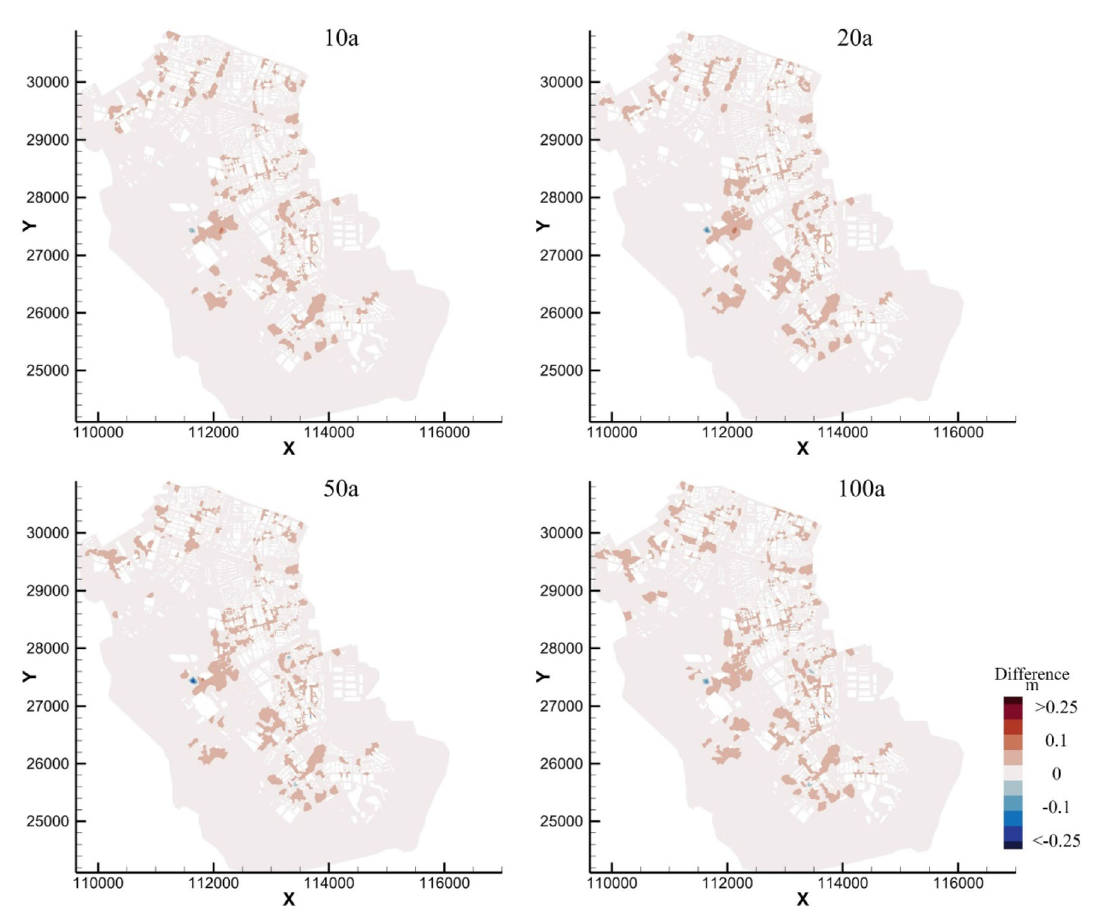
Fig. 12 Inter-comparison of the maximum inundation depth (obtained by the subtraction of the simplified urban stormwater model (SUSM) results from the urban stormwater model (USM) results) Table 4 Root-mean-square error (RMSE) values of the water depth and flow velocity for the simplified urban stormwater model (SUSM) compared to the urban stormwater model (USM) RMSE